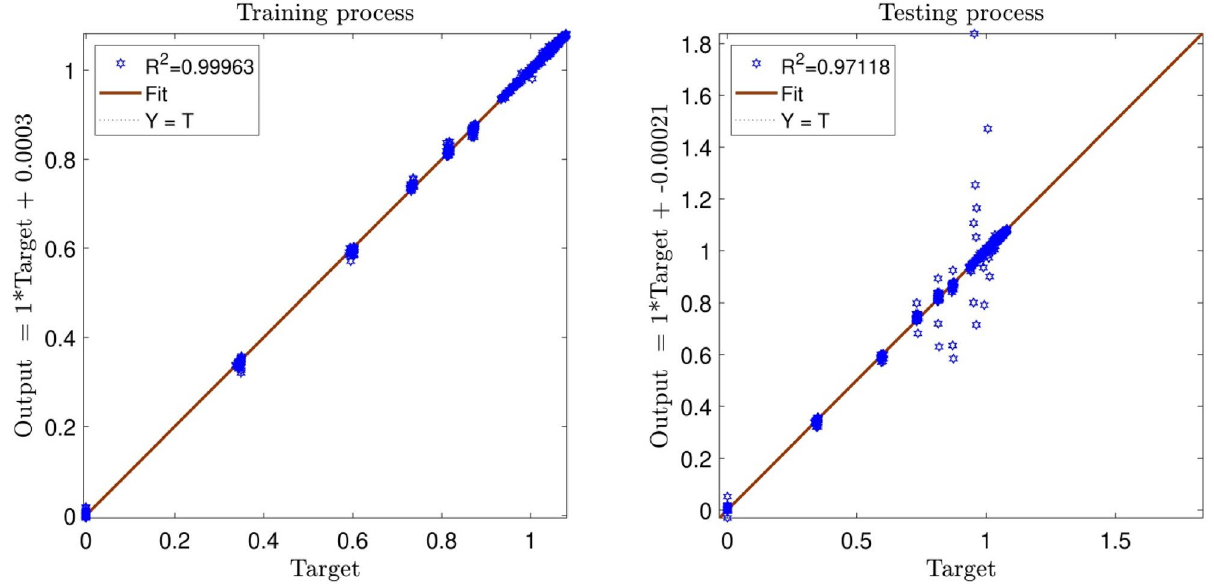
Figure 9. Determination of coefficient in the best GAFIS intelligence when P.S = 30, A.R = 0.6, P.C = 0.4, CIR = 0.15, S.F = 1.15, R.R = 0.05.